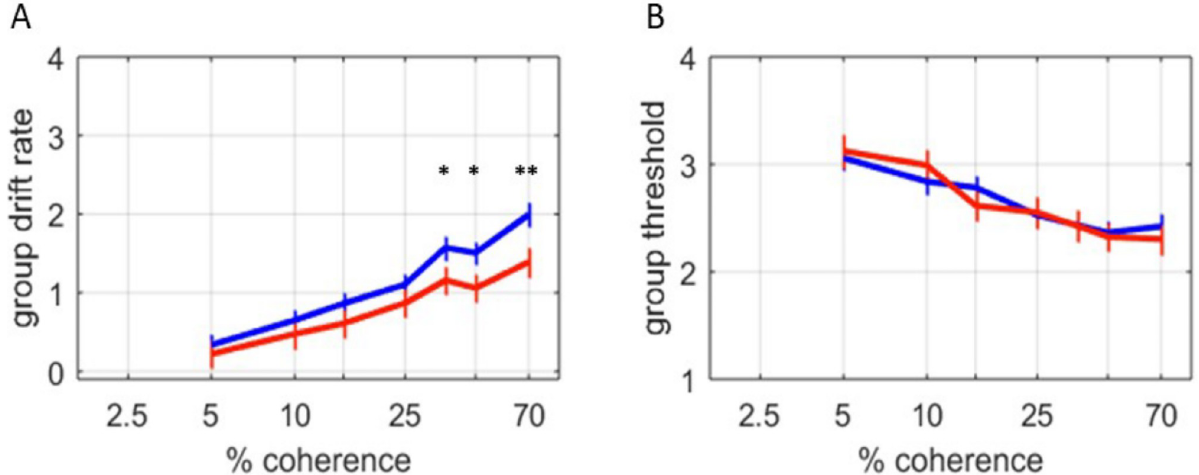
Fig 3. Behavioral task performance in OCD cases and controls. A) A posterior distribution of group mean drift rate was calculated using HDDM, and indicates the rate of evidence accumulation over 7 different coherences. The most likely group means are plotted; error bars indicate the posterior standard deviation. With higher coherence, higher drift rates were observed for both OCD (red, n = 26) and control (blue, n = 44) subjects. However, at higher levels of coherence, OCD subjects exhibited significantly slower drift rates and reaction times than OCD subjects (q < 0.05 for 30%, and 45% coherence; q < 0.01 for 70% coherence). B) No significant differences in the posterior distribution of HDDM threshold were observed between OCD and control subjects.